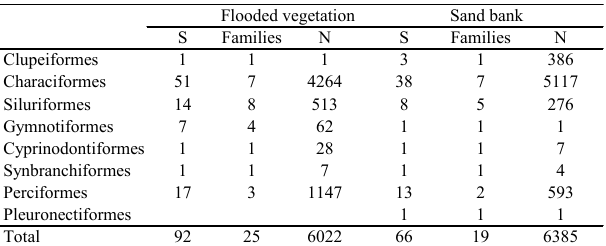
Table 2. Fish orders collected in Caño La Guardia and fish assemblage attributes for each sampled habitat